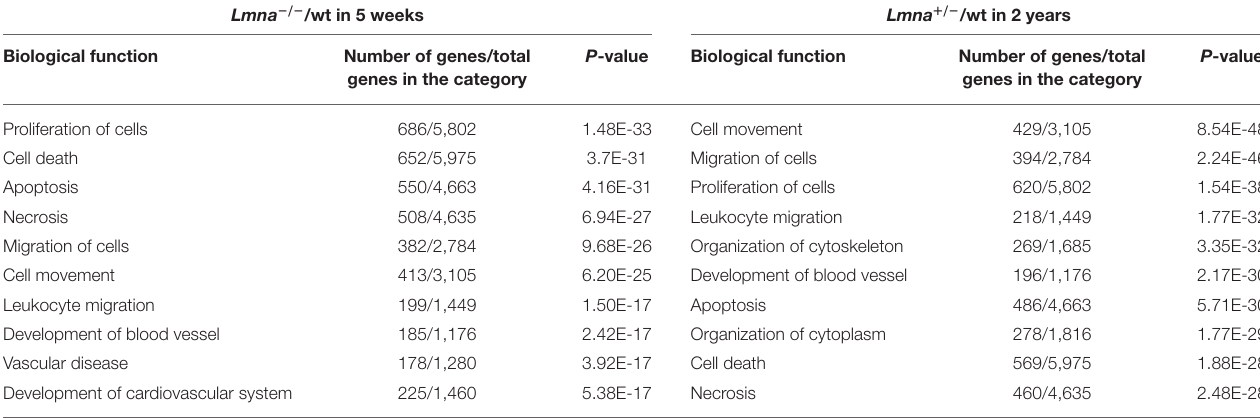
TABLE 2 | Top biological functions related to Lmna mutant mice in RNA-seq analysis. Lmna − / − /wt in 5 weeks Lmna + / − /wt in 2 years P -value Biological function Number of genes/total P Biological function Number of genes/total genes in the category genes in the category